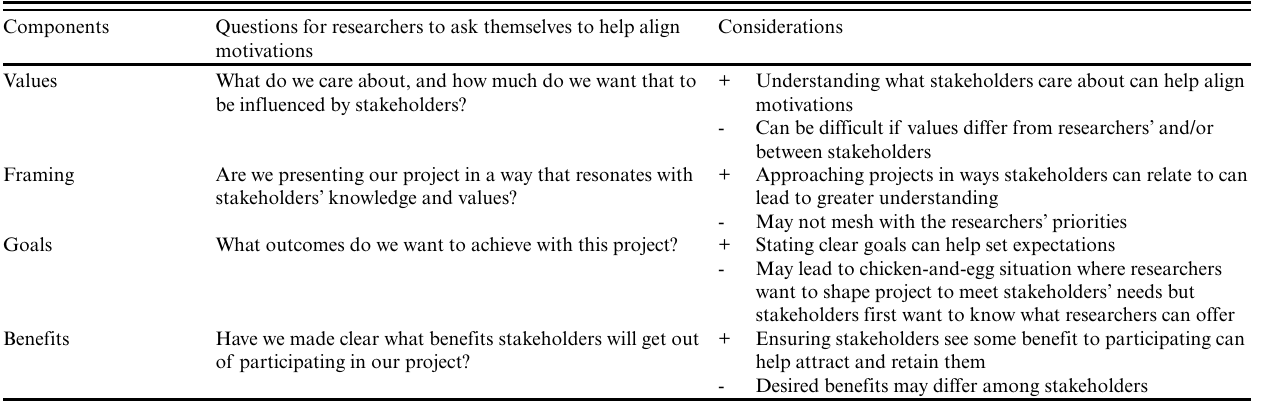
Table 4. Questions and considerations to guide researchers in aligning motivations, derived from the experiences of researchers leading 12 ecosystem services research case studies. Components